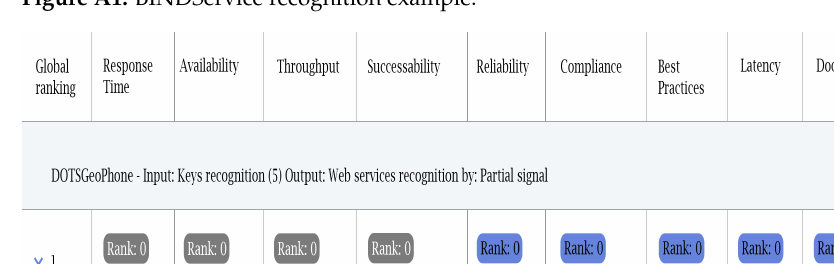
Figure A1. BINDService recognition example.